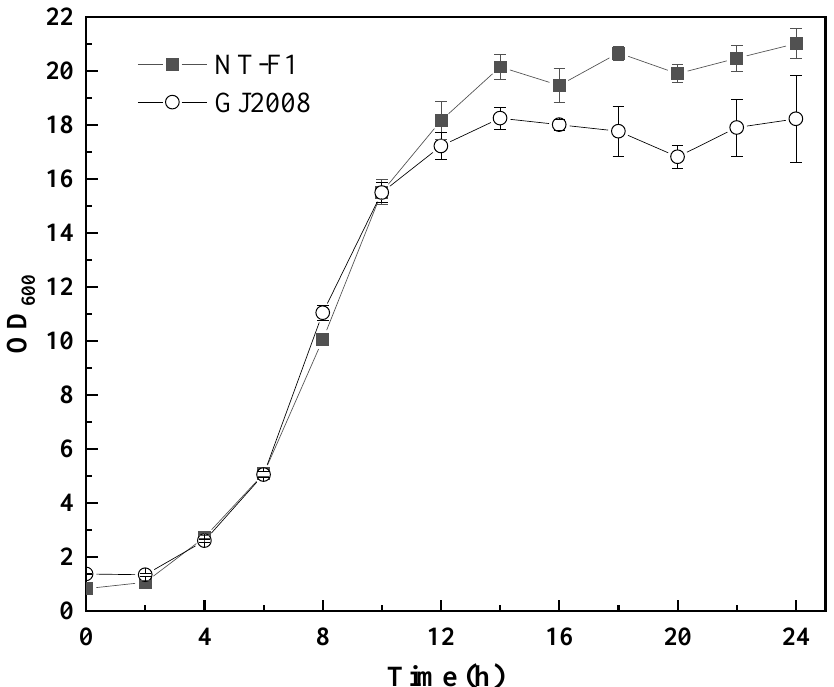
Figure 8. Comparison of growth capacity of mutant and non‑mutant strain. The mutant strain NT‑F1 compared with non‑mutant strain GJ2008 under 310 g/L sucrose.